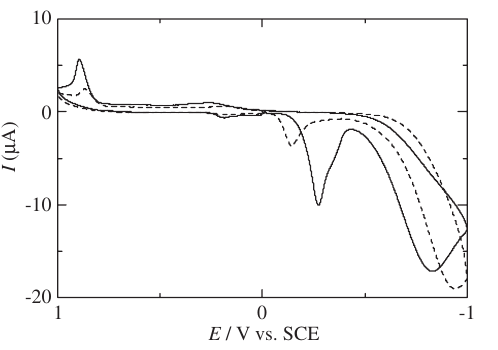
SO solution. The broken line 2 4